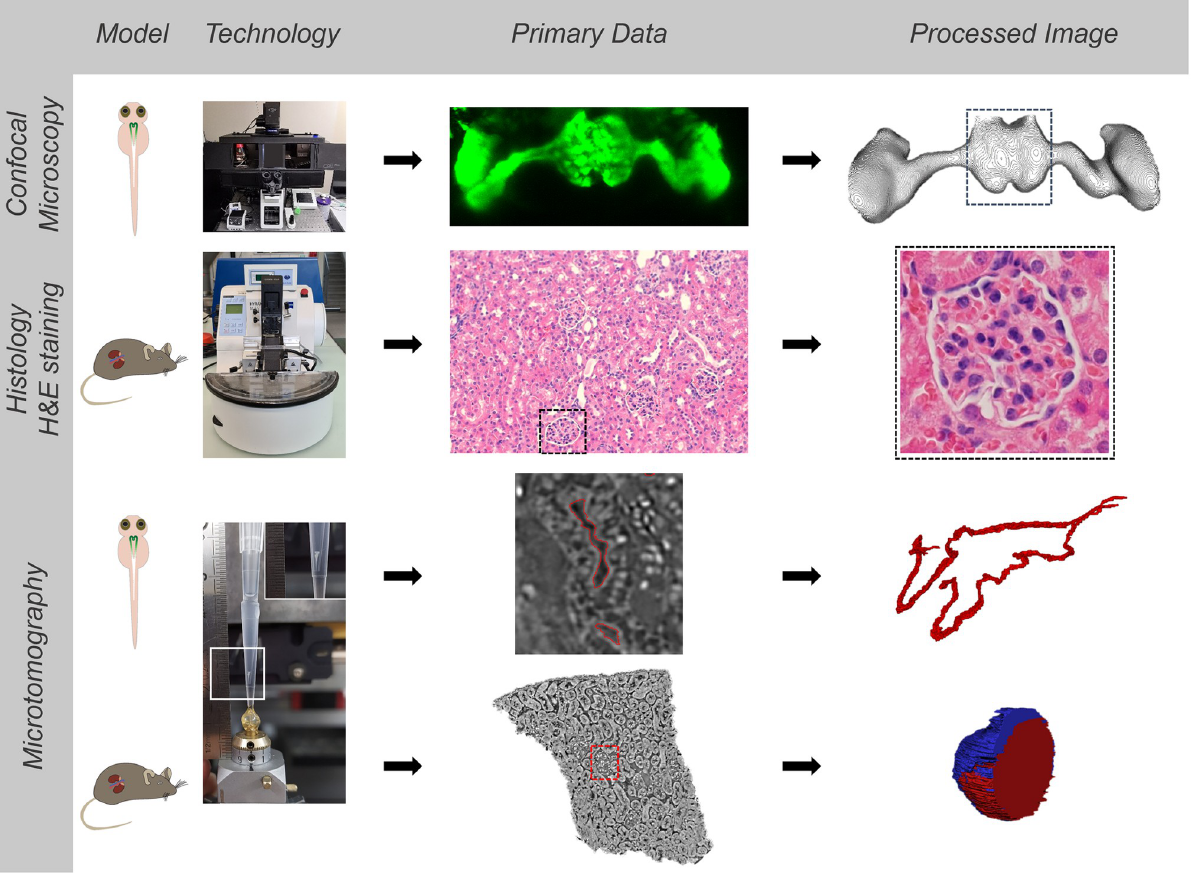
Fig 1. Analytical technologies, workflow, and outcome. Summary of employed imaging strategies to study toxic effects using zebrafish pronephros and mouse kidney biopsies. Methods include confocal laser scanning microscopy, synchrotron radiation-based computed tomography (SR μ CT), and semiquantitative image analysis of H&E/PAS stained histology